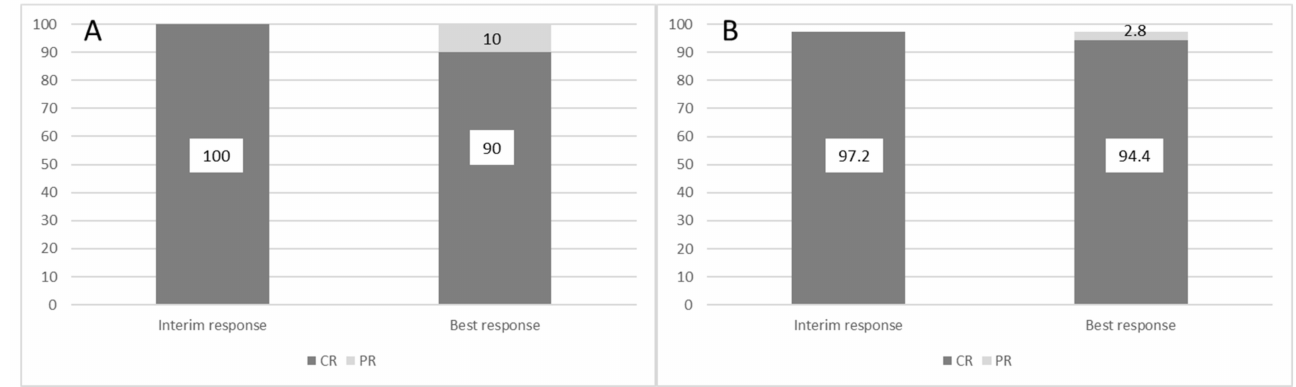
Figure 1. Response evolution between interim evaluation and best-achieved results in patients treated frontline (panel ( A )) and in those receiving ibrutinib as a second line or beyond (panel ( B )). Y-axis represents patients %.